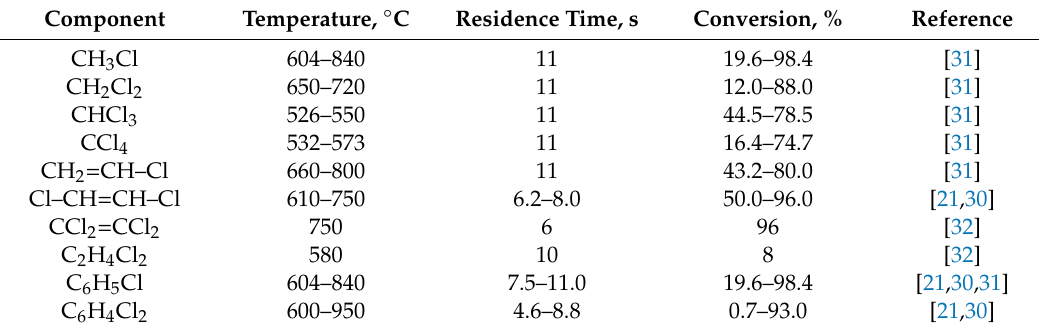
Table 2. Thermal hydrodechlorination of